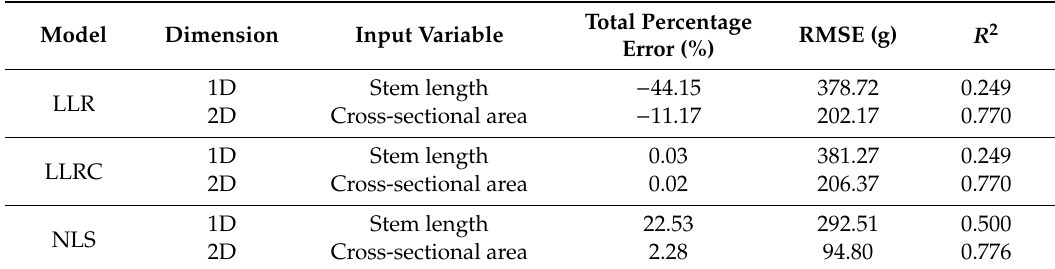
Table 6. Model performances for combined general shrub and tree total AGB prediction (all p values <